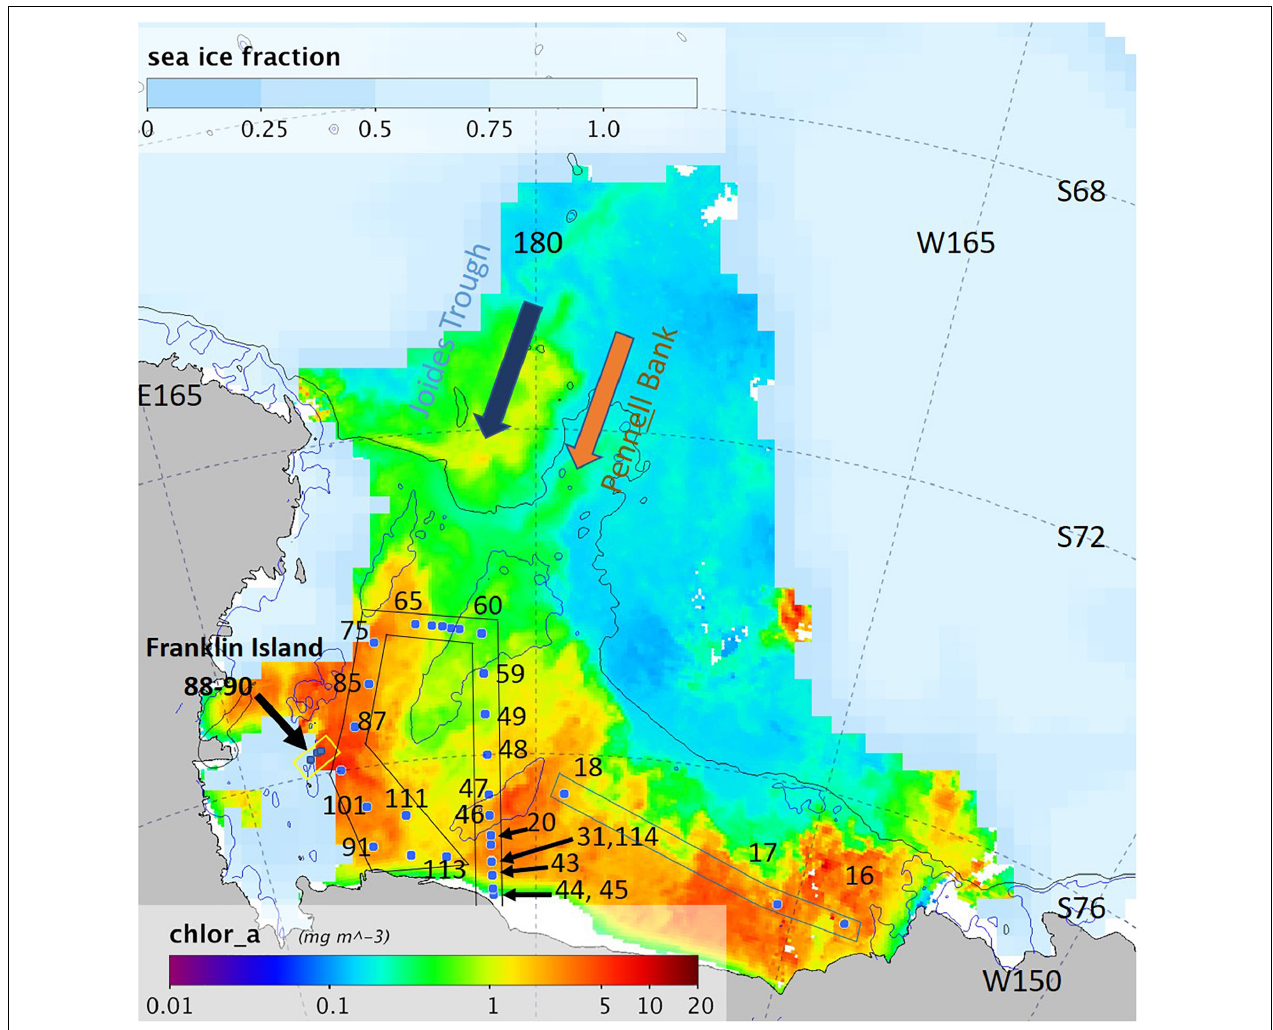
FIGURE 1 | The Ross Sea study area with the eastern Ross Sea (St. 16–18, indicated with a blue box) and a circle transect in the center of the Ross Sea Polynya (RSP) (St. 20–114, indicated with a black box), the east RSP transect was sampled from south to north (St. 20–60), the west RSP transect was sampled from north to south (St. 75–113). The Franklin Island transect (St. 88–90) is indicated with a yellow box. Chlorophyll composite image from 20 December 2013 to 5 January 2014 (MODIS/Aqua). Sea ice fraction from Dec 28, 2013 (SSMIS). Black line denotes 1000 m isobath and blue line 350 m